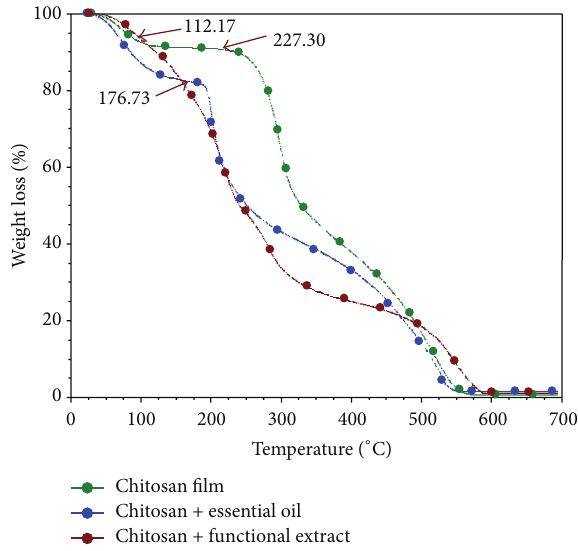
Figure 2: TGA curves for chitosan-based films and chitosan film plus the essential oil of clove. Universal V4.3A TA